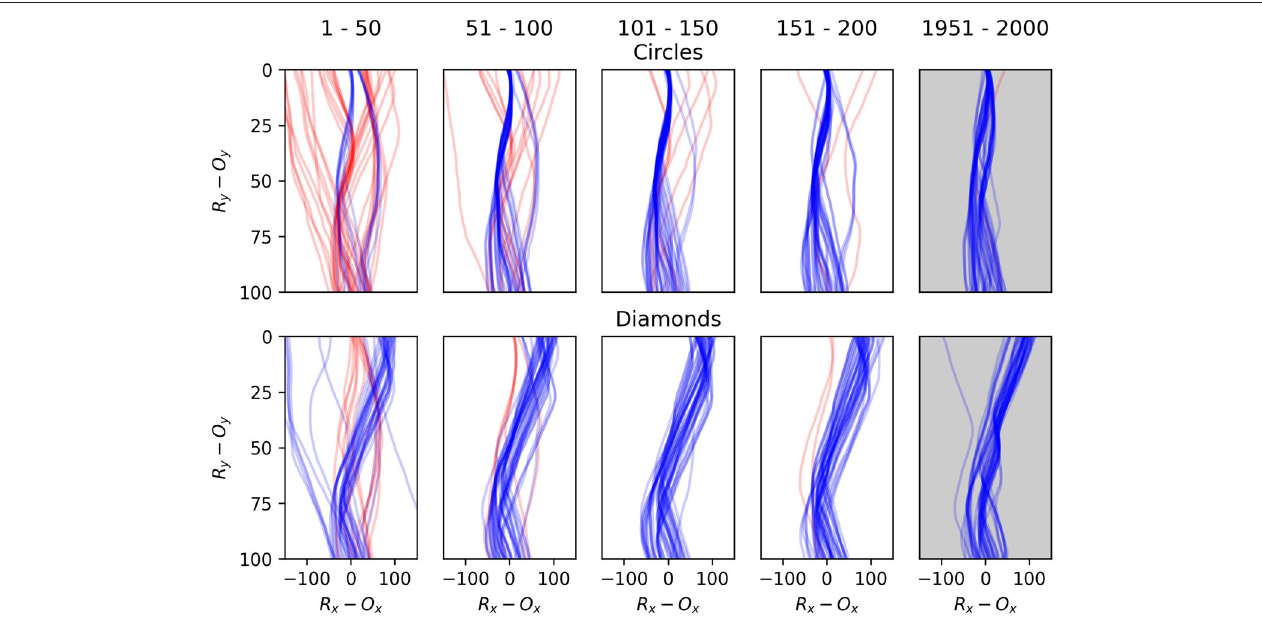
FIGURE 14 | Plots illustrating the behavior one robot as it interacts with the falling objects. The first column shows the robot’s first 50 interactions with circles in the top row and diamonds in the second row. The second column shows the second 50 interactions and so on. Each line illustrates a single interaction with an object from the moment that it is 100 units above the robot until the moment the object either collides with the robot or the bottom of the environment. Blue lines indicate that the object ultimately did the correct thing as per the task description, i.e., it collides with the circle or avoids the diamond. Following each plot from bottom to top shows the relative horizontal positions of the robot and object as the object descends toward the robot. The object’s position is always at 0 on the x-axis, so a point at x = 100 indicates that the robot is 100 units to the right of the object, and gives no indication of the robot’s absolute position in the